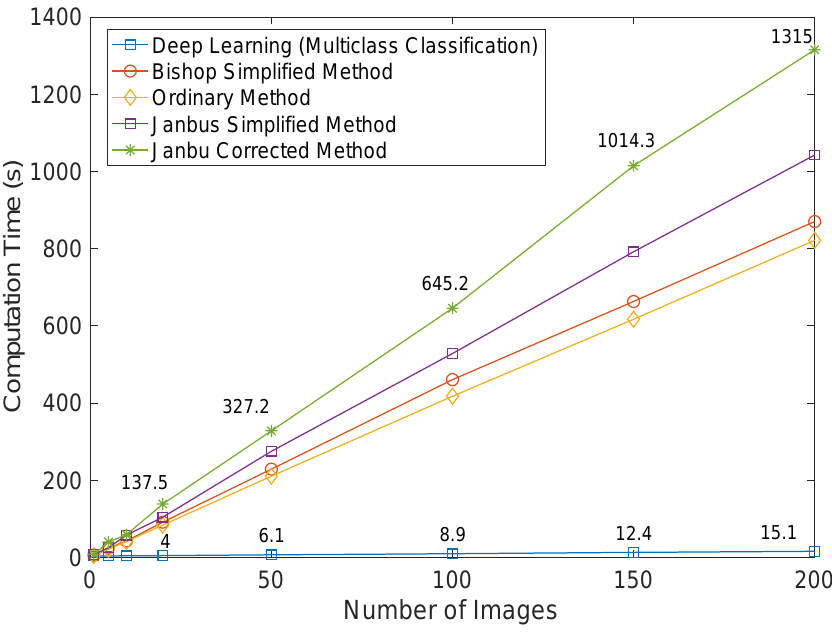
Figure 11. Computing time for the classification model and the LEM code.